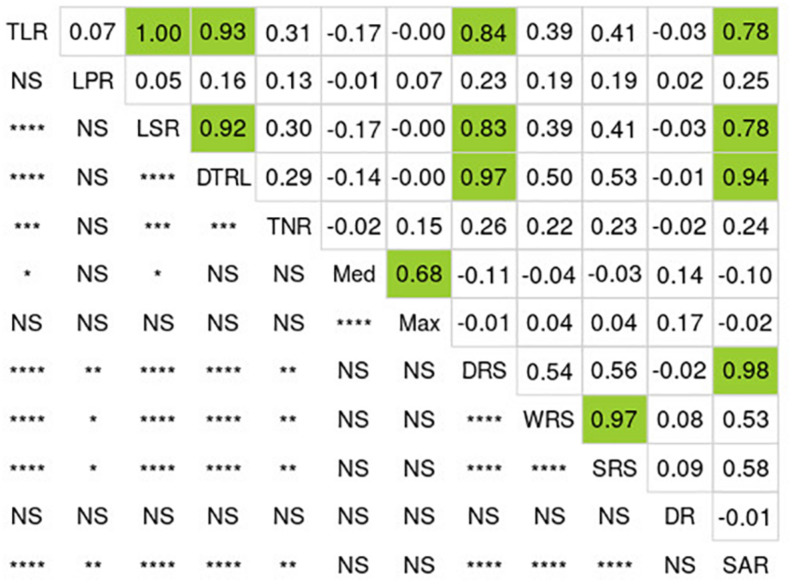
Correlations among RSA-related traits for the 137 soybean lines. Numbers above the diagonal correspond to Pearson’s correlation coefficients (R). Green boxes highlight the values exceeding 0.65. Below the diagonal, we show the degree of significance of the corresponding correlations between traits (****P < 0.0001, ***P < 0.001, **P < 0.01, *P < 0.05, and NS: not significant). TLR, total length of roots; LPR, length of primary root; LSR, length of secondary roots; DTLR, distribution of total root length; TNR, total number of roots; Med, median number of roots; Max, maximum number of roots; DRS, depth of root system; WRS, width of root system; SRS, surface of root system; DR, diameter of primary root; SAR, surface area of primary root.